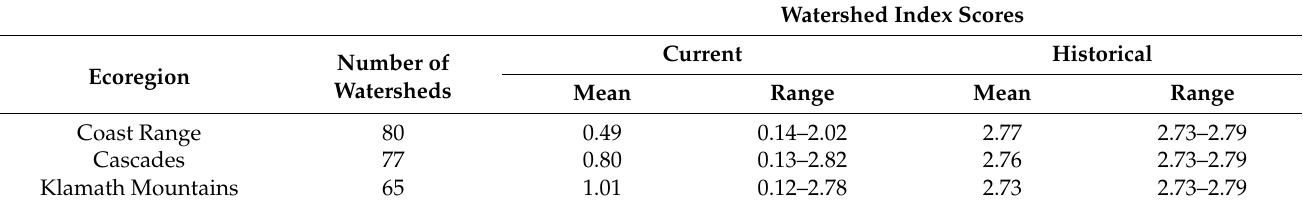
Table 5. Summary of the watershed index scores by ecoregion for red tree vole ( Arborimus longicaudus ) in the evaluation area in Oregon and California,